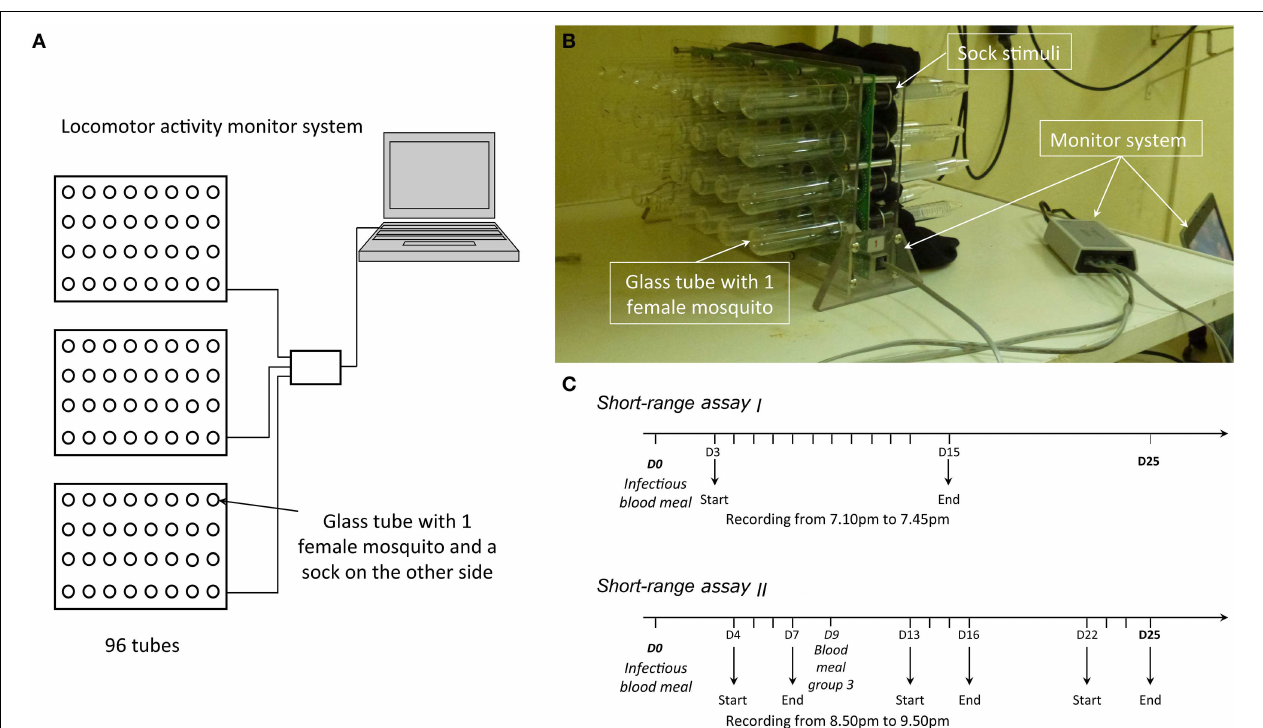
FIGURE 2 | (A) Schematic representation of the locomotor activity monitor system. (B) Photo of the device. (C) Schematic representation of the testing